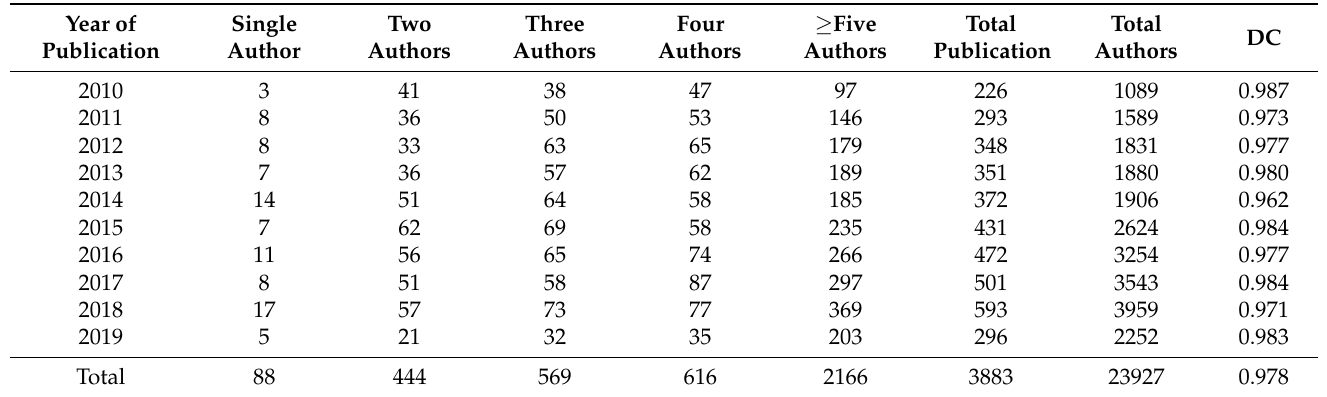
Table 2. Chiang Mai university’s co-authorship pattern from the year 2010 to 2019.